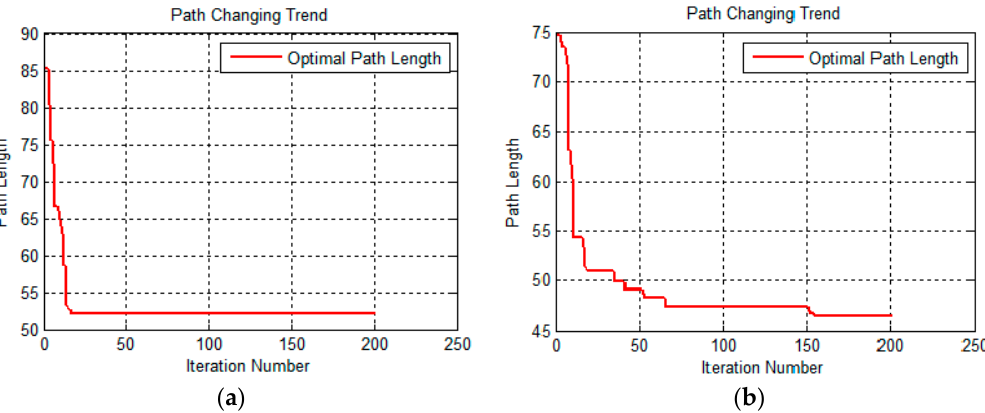
Figure 10. The optimal path length change with iteration number. ( a ) A relation curve of the basic ant colony algorithm; and ( b ) a relation curve of the improved ant colony algorithm.